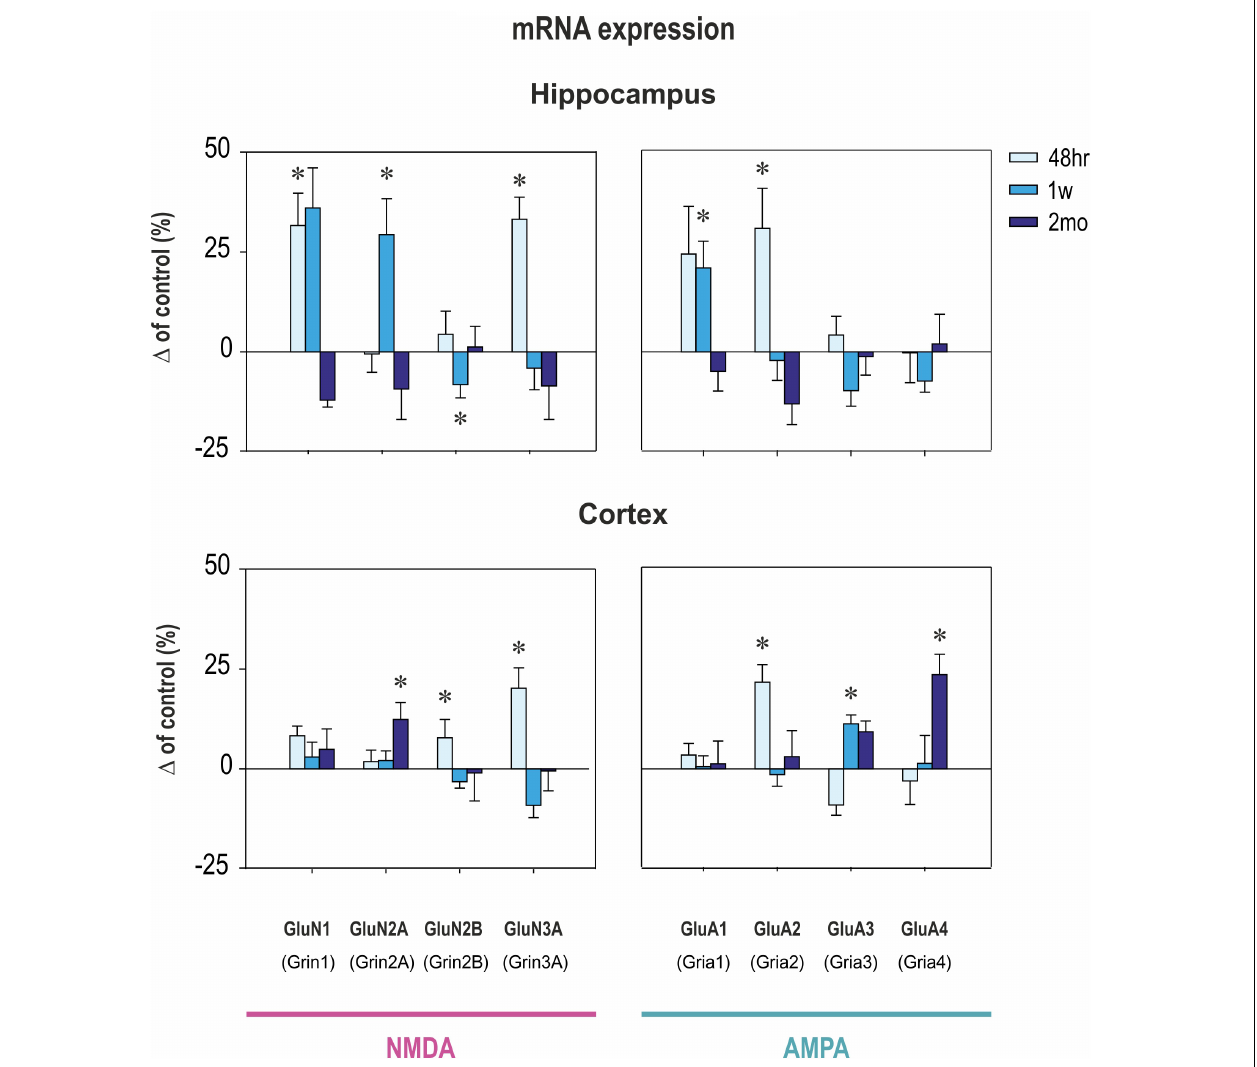
FIGURE 3 | Transcriptional levels of NMDA and AMPA receptor subunits in hippocampus and cortex at three intervals after CZP cessation. mRNA levels were determined using quantitative RT-PCR and values were converted to a percentage of the control values, which were considered as baseline (zero) levels. Data are presented as means ± SEM. Asterisks denote significant differences compared to